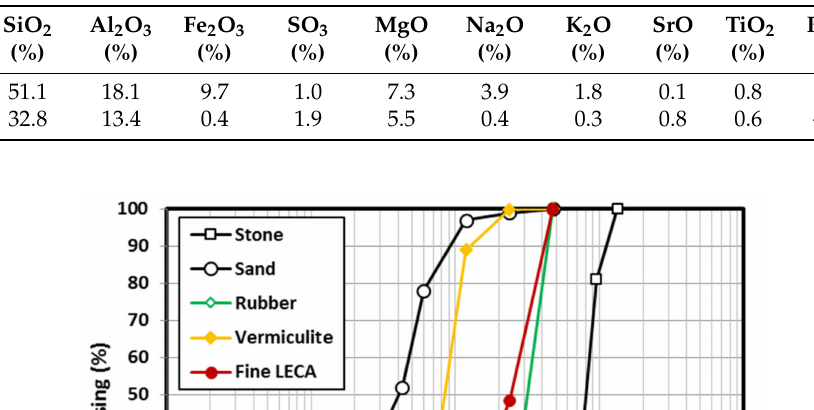
Table 1. Chemical composition of geopolymer binders.